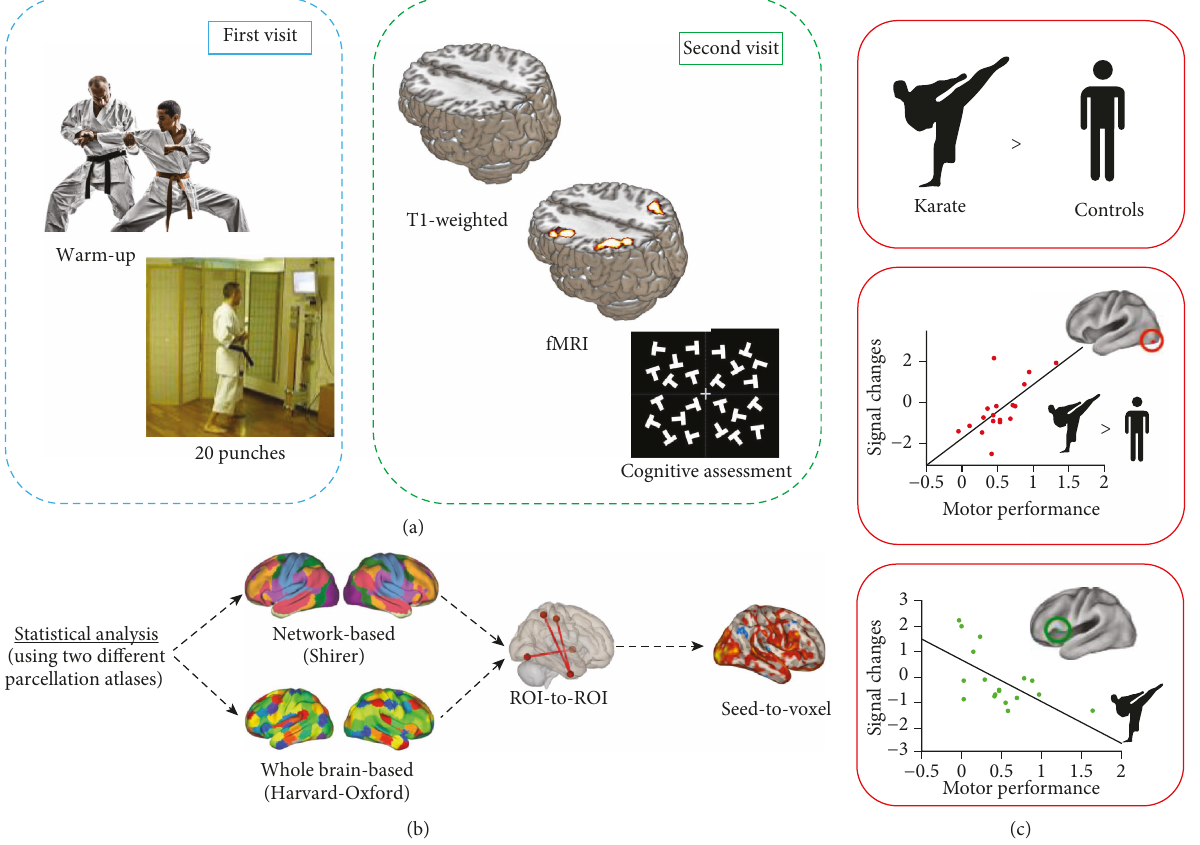
Figure 1: Study overview. Schematic representation of the experimental timeline (a), statistical analyses (b), and contrasts (c) (see supplemental material).